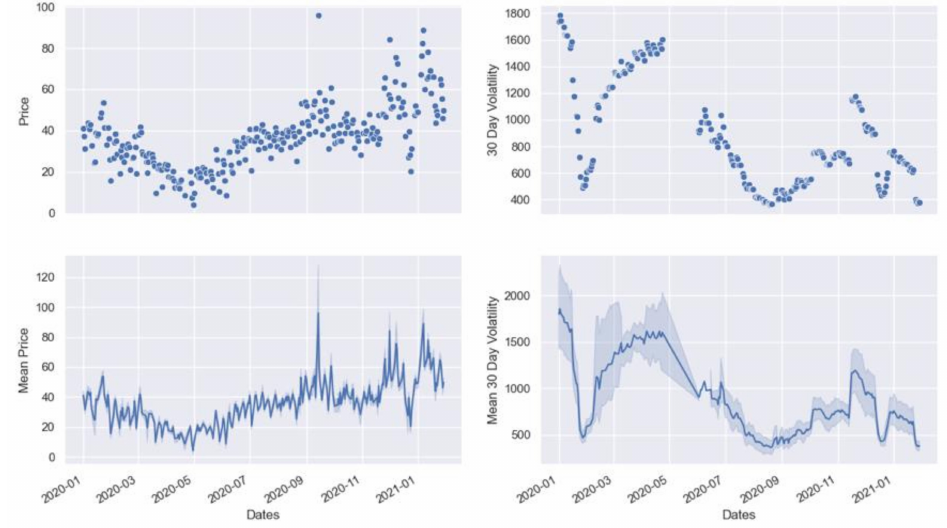
Figure 11. This figure represents the intraday price levels for French power including its confidence levels on the left side and the 30-day volatility including its confidence levels on the right side.